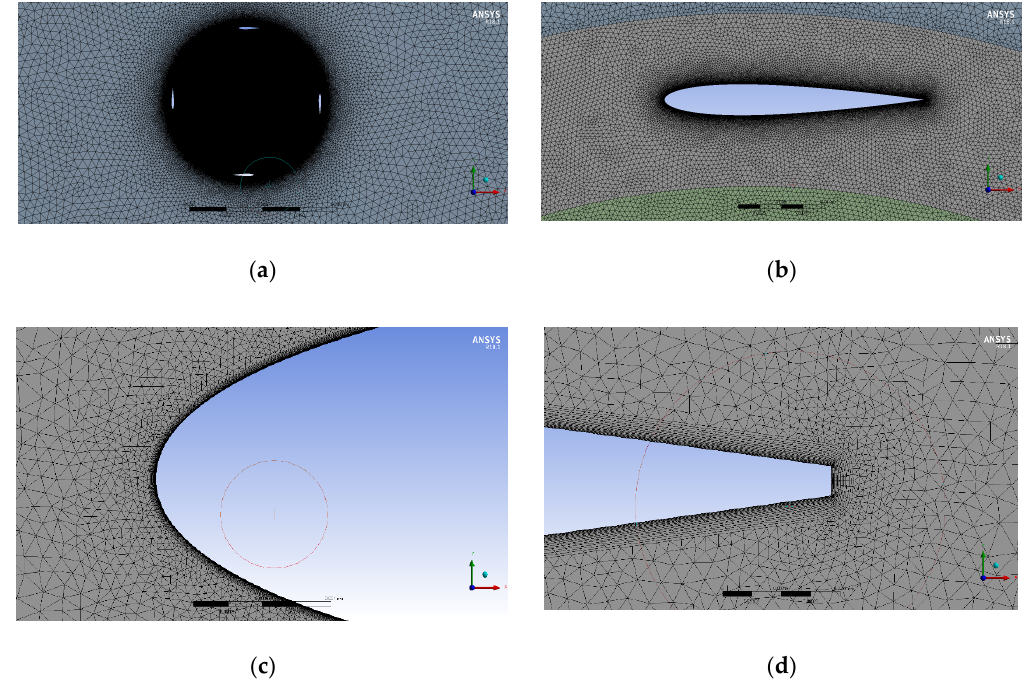
Figure 4. Details of the rotor region ( a ), airfoil region ( b ) leading edge ( c ) and trailing edge ( d ) for mesh M2.